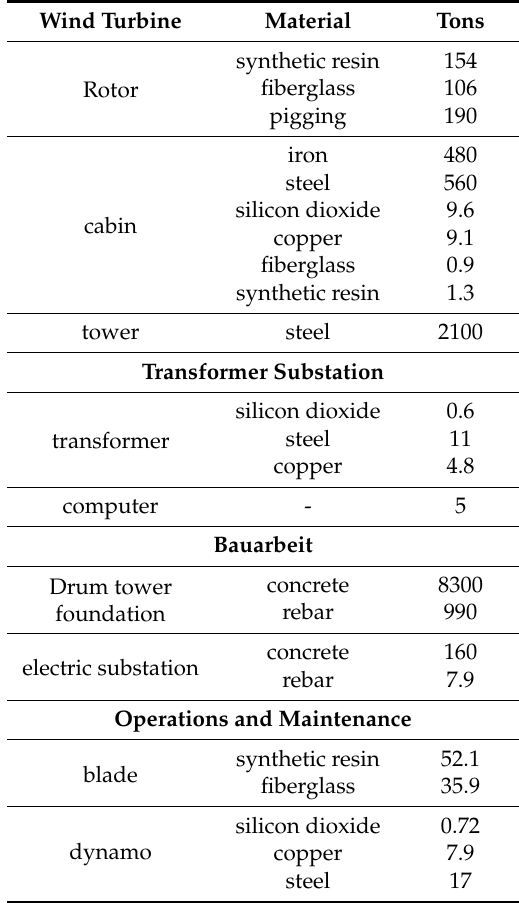
Table A7. Lifecycle greenhouse gas emissions of onshore wind